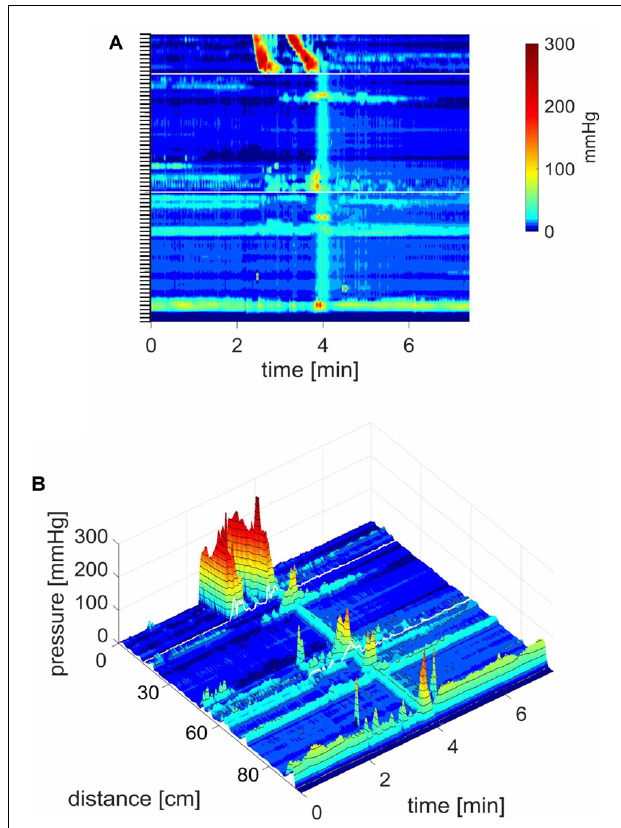
FIGURE 4 | A proximal HAPW and an HAPW-SPW in response to a meal. (A) Two very similar proximal HAPWs appeared in response to a meal, but only one developed into an SPW. The SPW was accompanied by external sphincter contraction and by sphincter relaxation and gas expulsion. The SPW started at the end of the HAPW, hence it was not pan-colonic. The first HAPW was not asssociated with gas expulsion. Position of the pressure sensors is shown on the left side. (B) 3D rendering of (A) . The 0 cm position is in the proximal